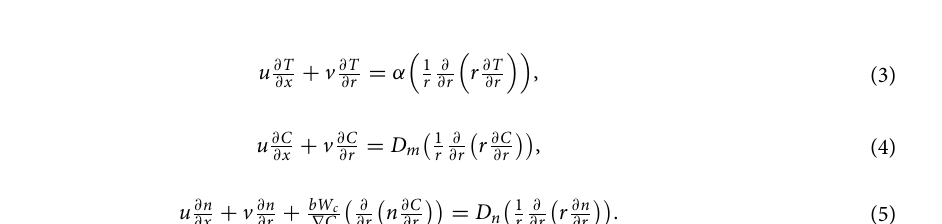
Figure 1. Physical model and coordinate